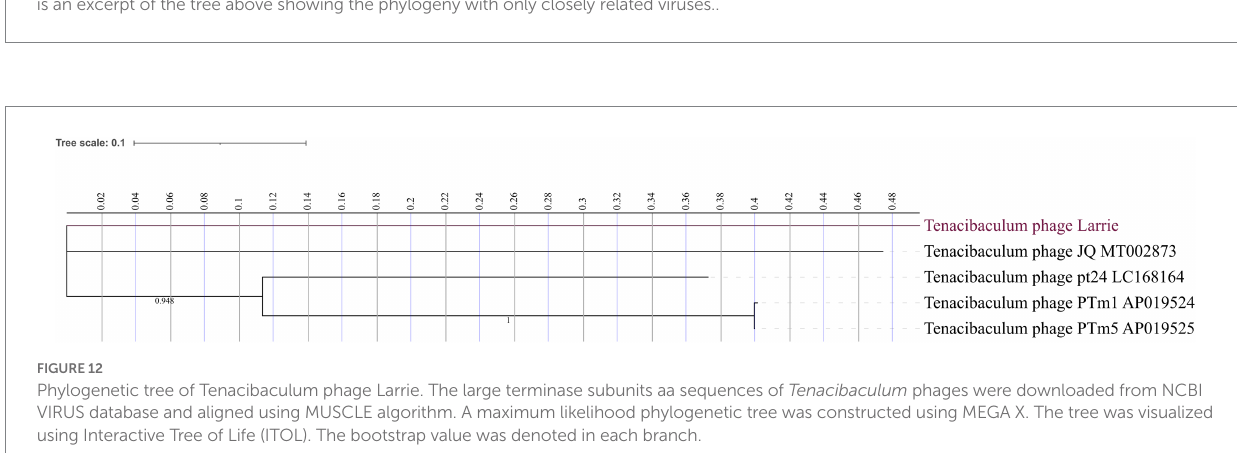
FIGURE 11 Phylogeny of Tenacibaculum phage Larrie based on proteomic tree constructed by VIPTree. (A) Larrie belongs to the Siphoviridae taxonomic family and can infect Flavobacteriaceae group (red star and line). The phage proteome was compared with 4,892 dsDNA phage proteomes (circular tree). The branch length scale was calculated as log values. The inner and outer ring indicate the corresponding taxonomic virus family and host group. (B) Below is an excerpt of the tree above showing the phylogeny with only closely related viruses..